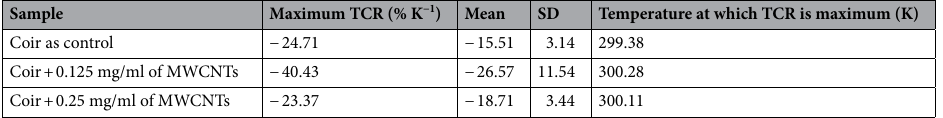
Table 1. Comparison of bolometric materials and TCR. *The current work reports perhaps the highest value found in TCR as bolometric response reported to date.